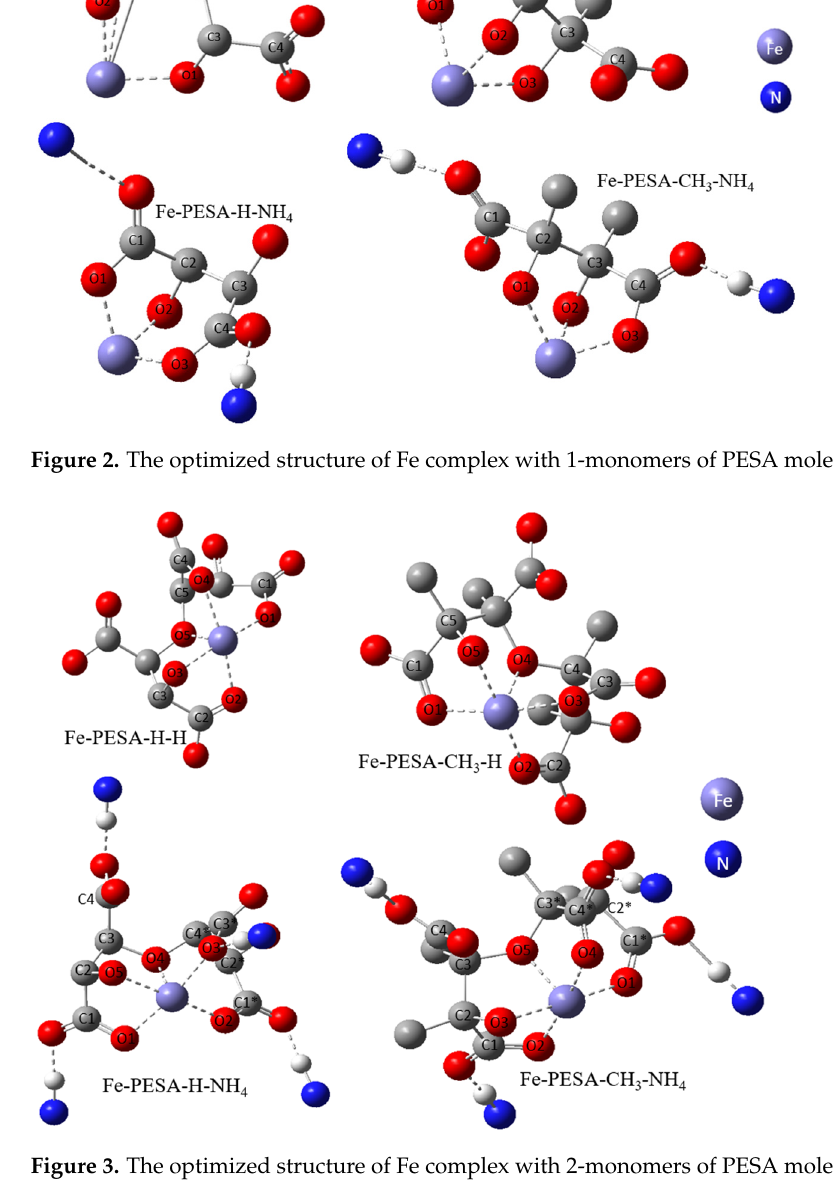
Figure 3. The optimized structure of Fe complex with 2-monomers of PESA